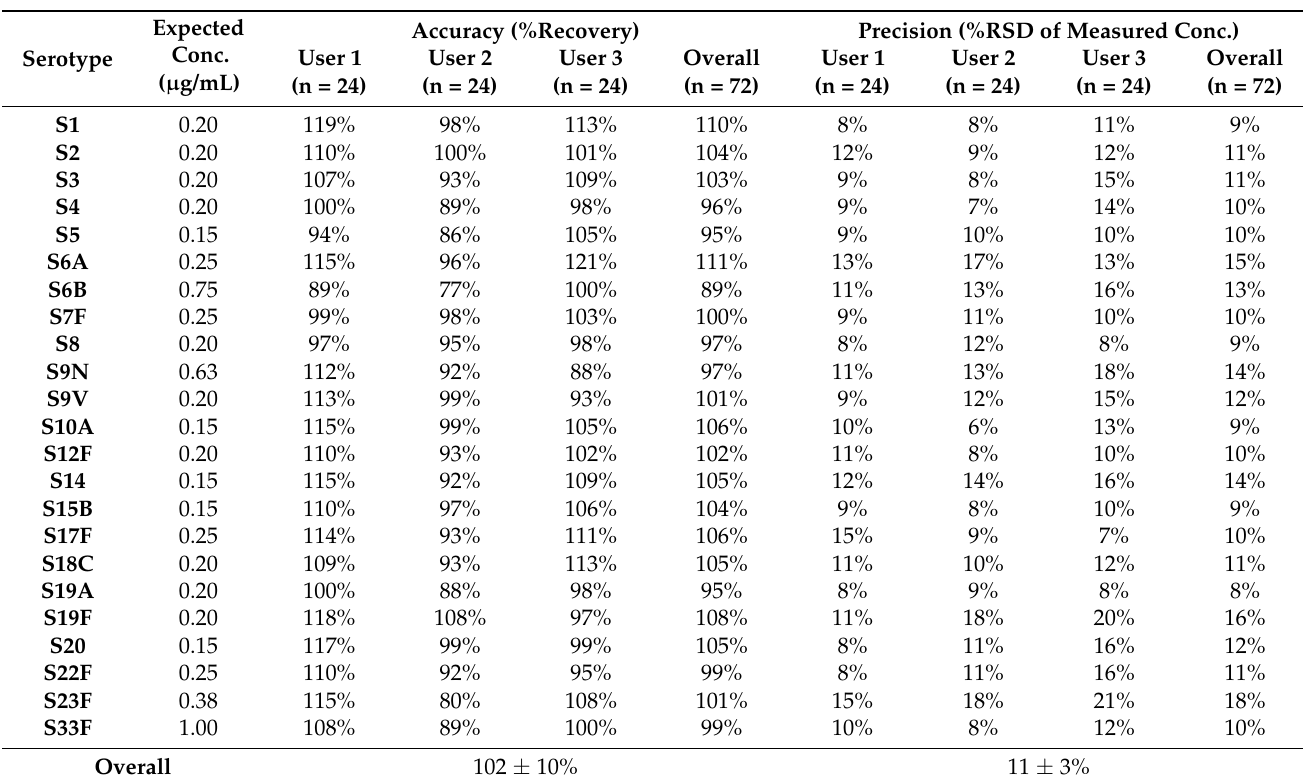
Table 3. Accuracy and precision for 23-valent Pfizer native PS materials (ATCC, deposited by Pfizer) over multiple users and multiple